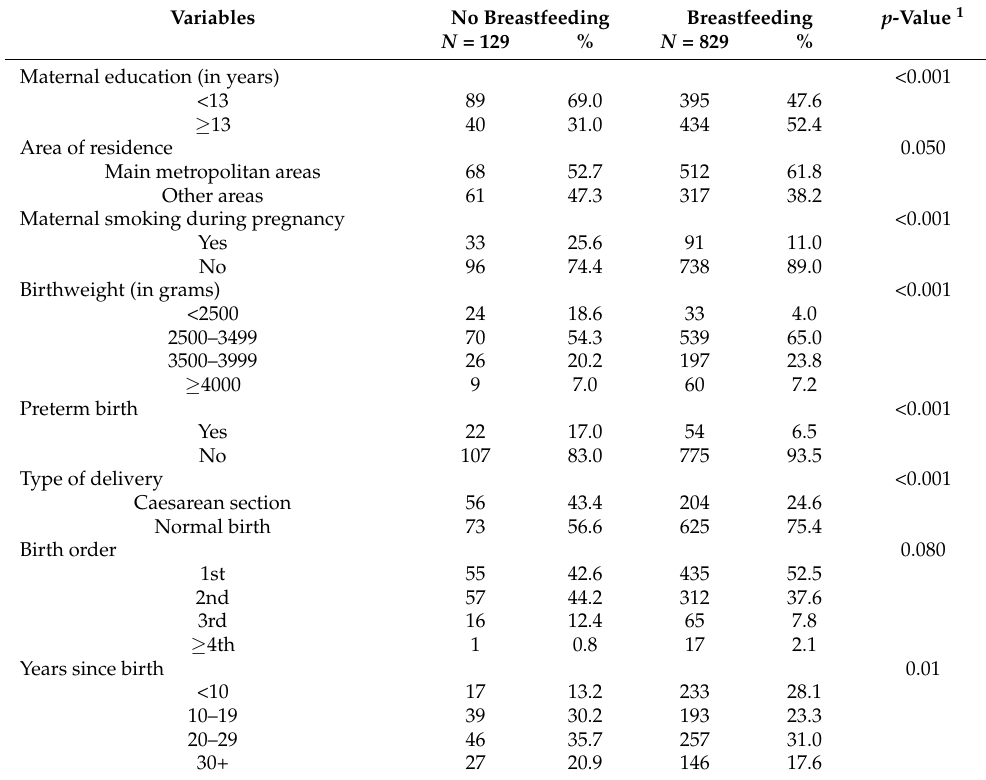
Table 1. Distribution of maternal sociodemographic characteristics and lifestyle habits during preg- nancy and perinatal characteristics among 958 children by breastfeeding initiation status.